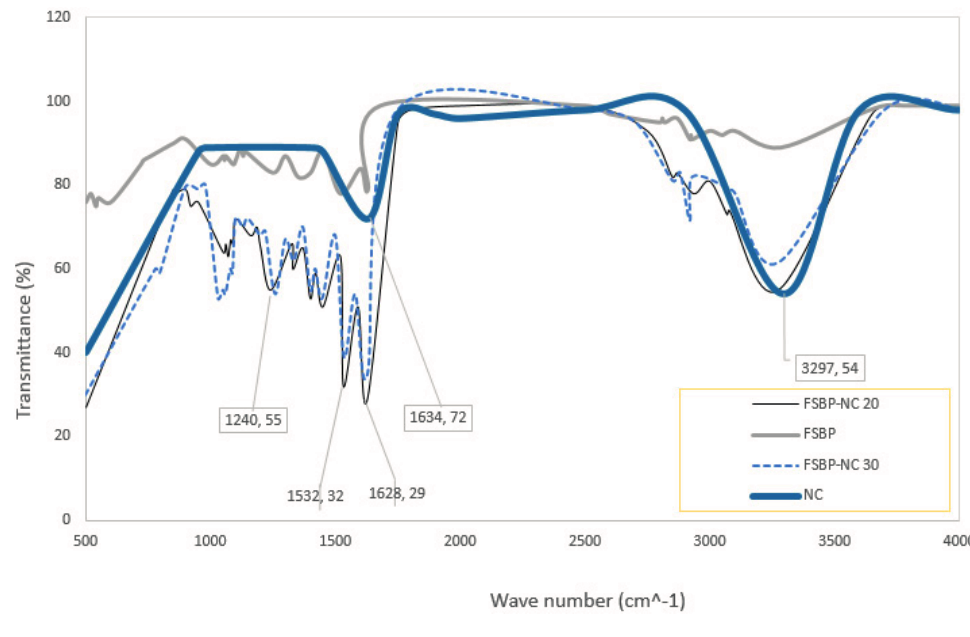
Figure 5. FTIR of NC and FSBP with 20 and 30 g NC